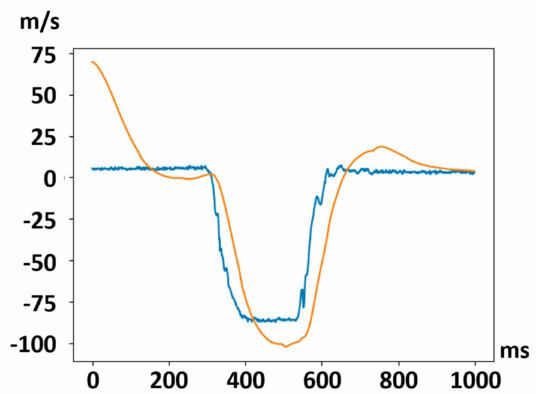
Figure 18. Output response of single-layer EKF with actually swaying within ± 40 degrees.